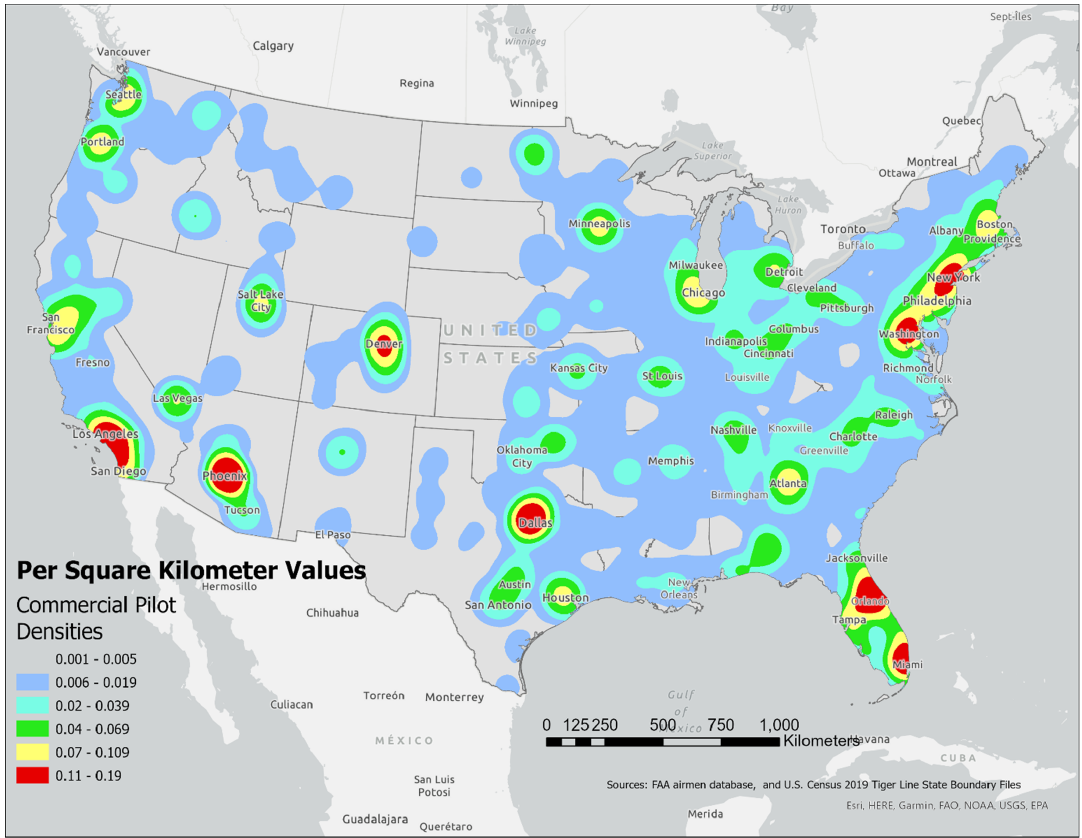
Figure 5. Kernel Density of FAA Registered Commercial Pilots. Kernel Density patterns for Registered Manned Pilots, which includes all forms of registered manned pilots excluding student and recreational, showed a similar clustering pattern (Figure 6). The number of registered pilots is much higher than commercial pilots, yet the same clustering can be seen in urban areas, particularly in the Northeastern United States and Florida. The clustering has its highest density in the Dallas Fort Worth metro area, but Florida has the largest cluster of registered